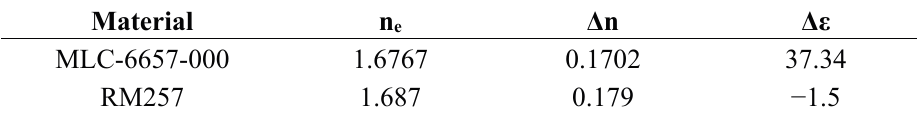
Table 2. Physical properties of each materials used in this